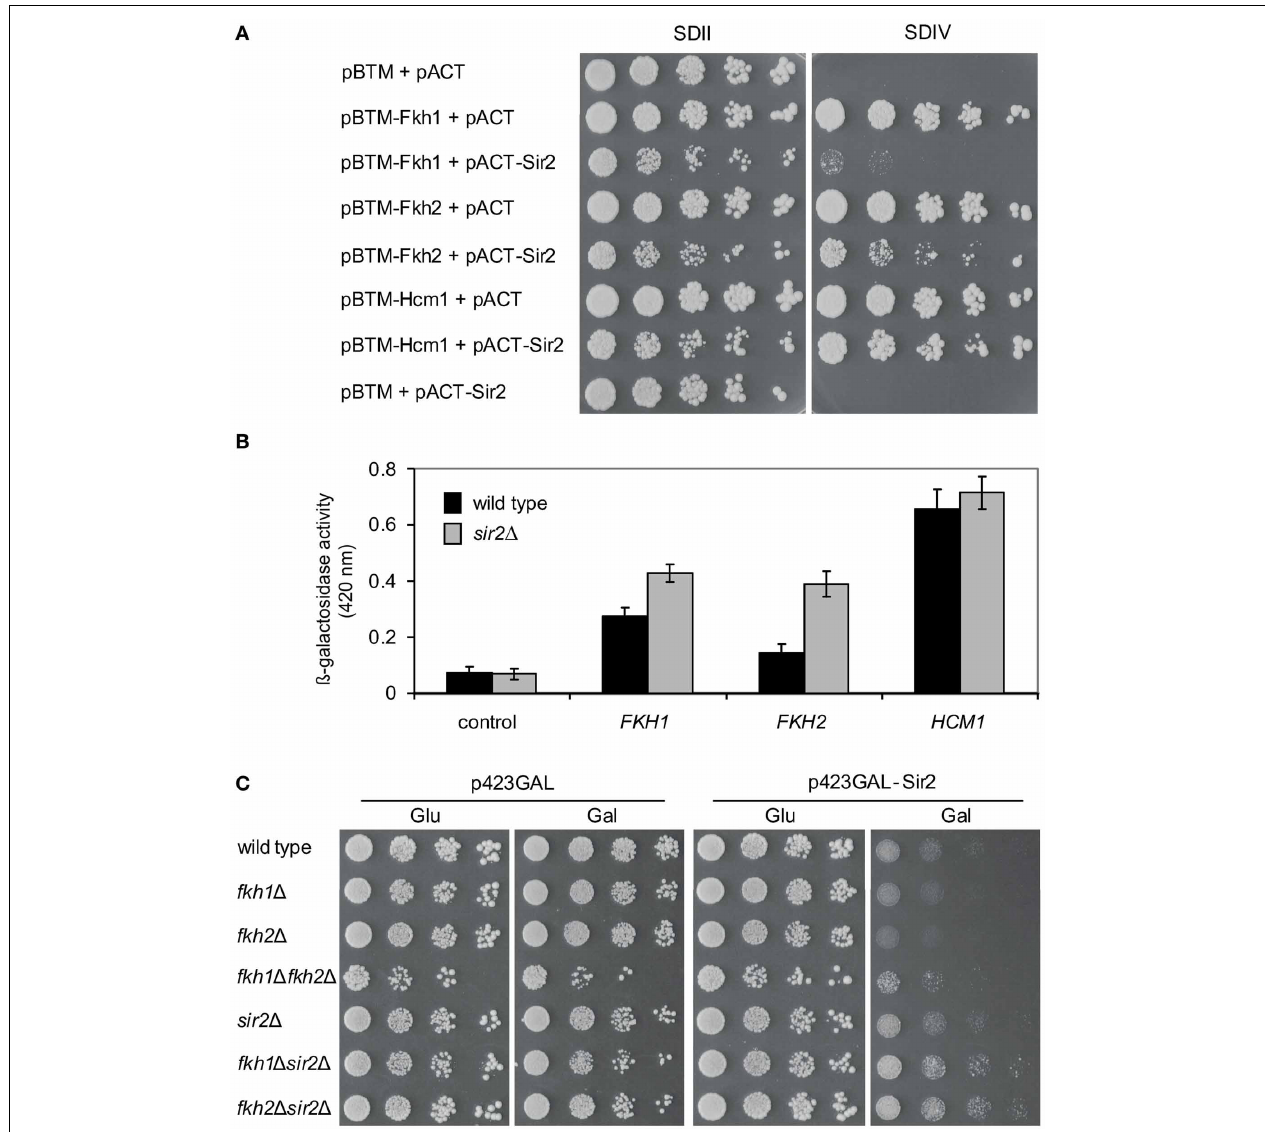
FIGURE 2 | Sir2 represses gene transcription via Fkh transcription factors. (A) Reporter gene activity assay. Yeast cultures were spotted